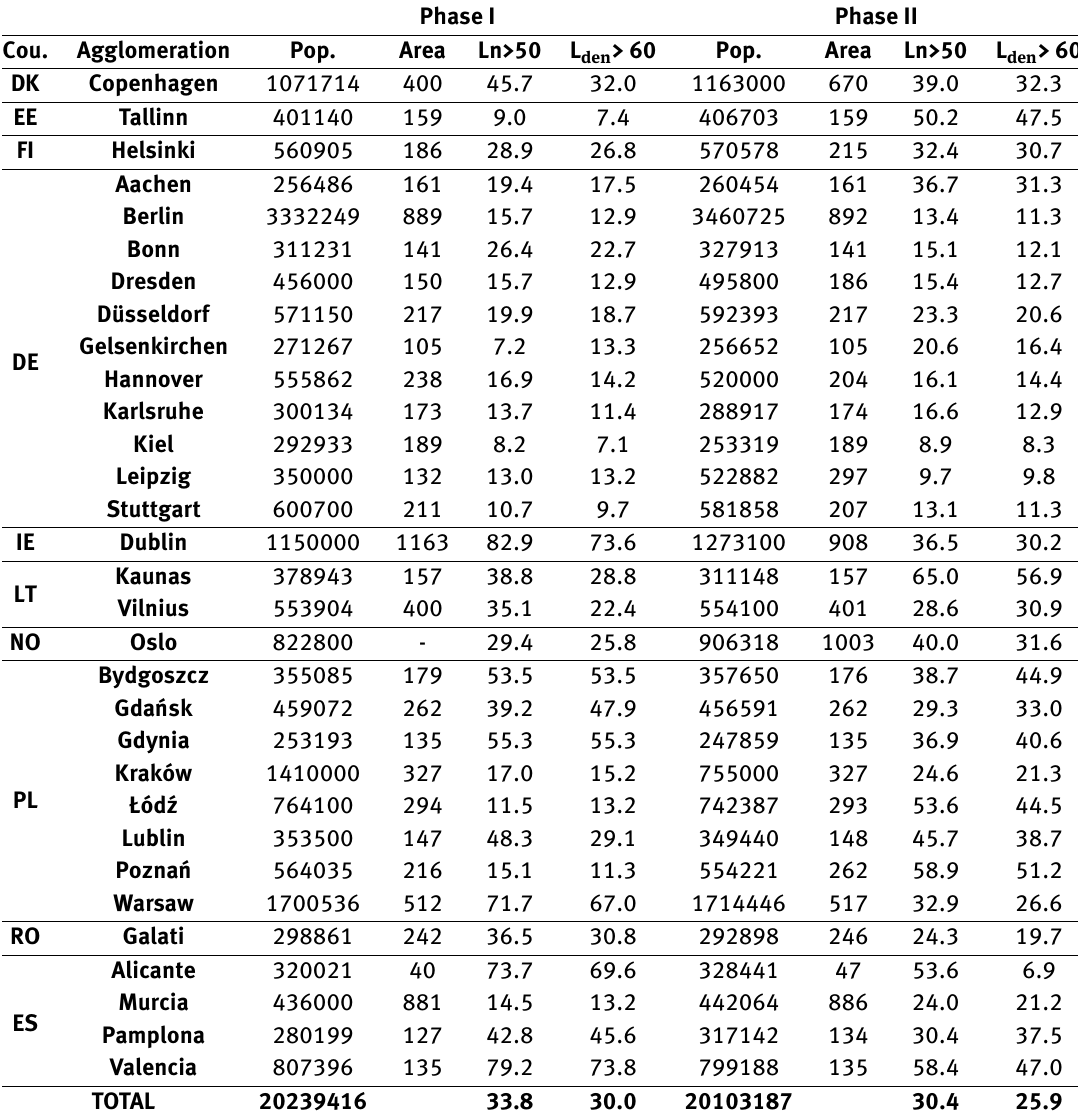
Table 3: Comparison of percentages of the population exposed to traflc noise ( L n > 50 and L den > 60 dBA) between Phases I and II in Euro- pean agglomerations. Area in km 2 .